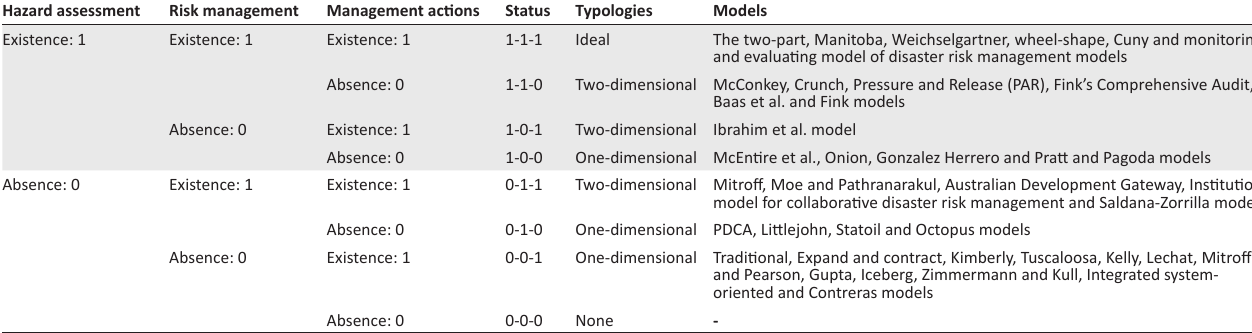
FIGURE 2: Disaster management thematic network. TABLE 3: Typology of disaster management models (first